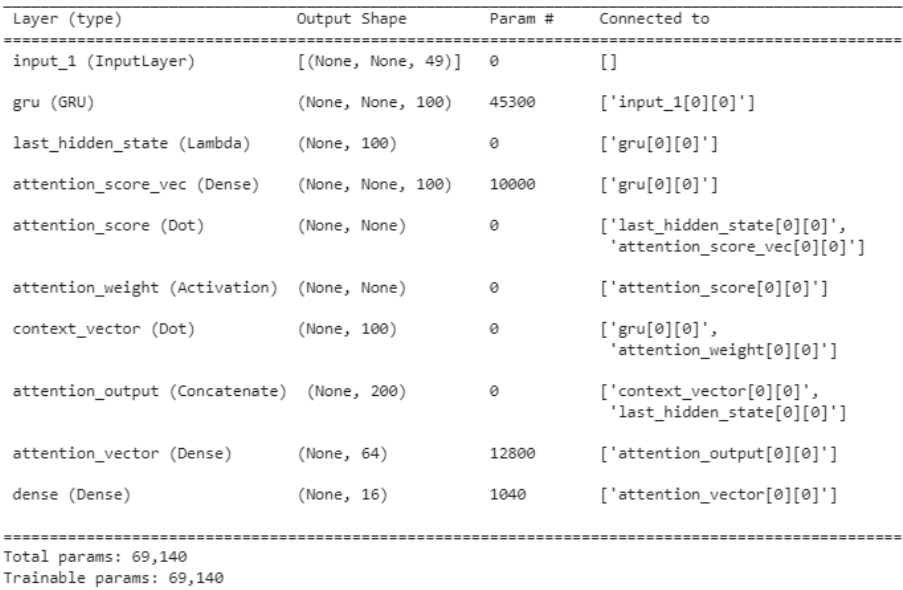
Figure 6. Details of the shape and layer connections in the attention-based multivariate time series forecasting